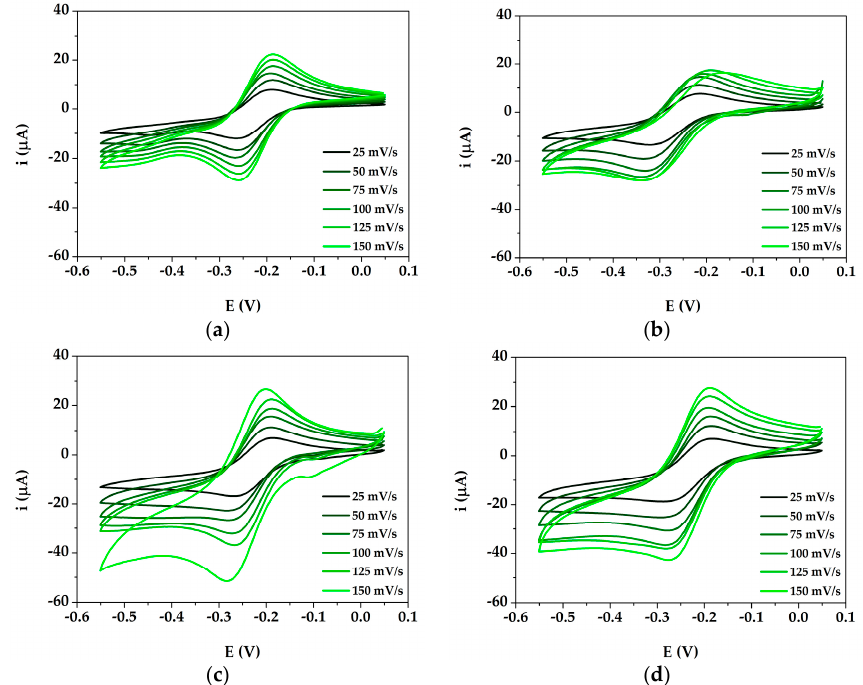
Figure 3. Cyclic voltammograms of bare and modified GSPEs in 1 mM [Ru(NH 3 ) 6 ] 2 +/ 3 + with 0.1 M KCl. ( a ) GSPE; ( b ) PANI / GSPE; ( c ) AuNPs / GSPE; ( d ) AuNPs@PANI / GSPE. Experimental parameters: potential range from − 550 mV to + 50 mV; scan rates 25, 50, 75, 100, 125 and 150 mV /